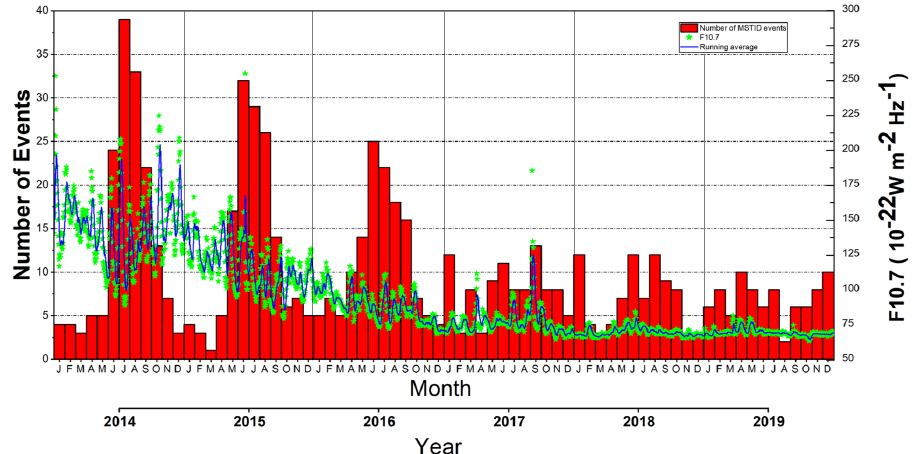
Figure 6. Solar cycle 24 dependence on occurrence. The monthly occurrence rate of the MSTIDs are indicated by the red histogram; the green represents the solar flux (F10.7), while the blue is the respective eigthy-one day